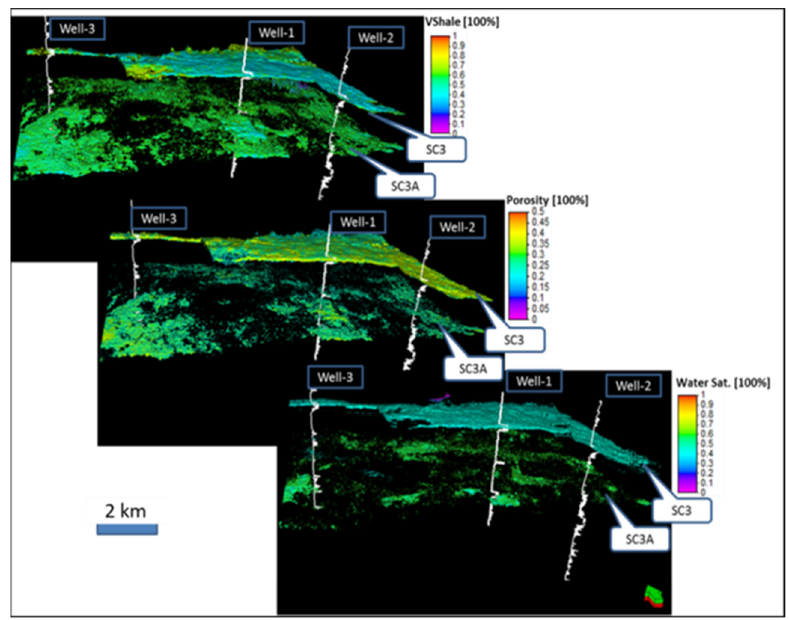
Figure 17. Petrophysical geobody constructed using discovery well cutoff value, Volume of shale <70% (top), porosity >12% (middle), water saturation <70% (bottom). SC3 and SC3A are, consecu- tively, thick and thin reservoir gas sand.